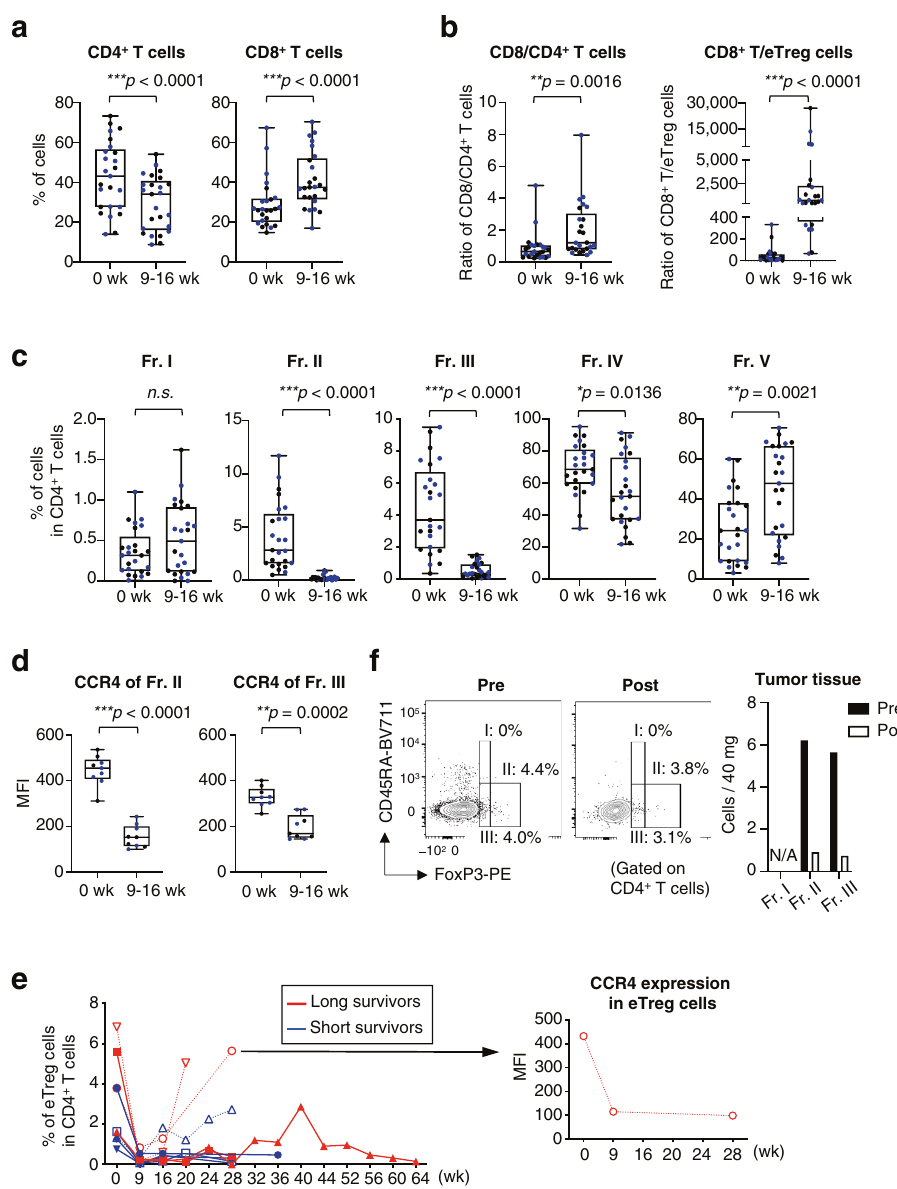
CD45RA and FoxP3 in CD4 + T cells (left) and changes of the absolute number of each FoxP3 + T cell fraction (right) are shown. In ( a – d ), black dots, patients who received 1.0 mg/kg mogamulizumab; blue dots, patients who received 0.1 mg/kg mogamulizumab and two-sided Mann – Whitney test was used. In a – d , the center line indicates the median, and the box limits indicate the 1st and 3rd quartiles. The whiskers go down to the smallest value and up to the largest. week: wk. * p < 0.05, ** p < 0.005, *** p < 0.0001. Source data are provided as a Source Data fi